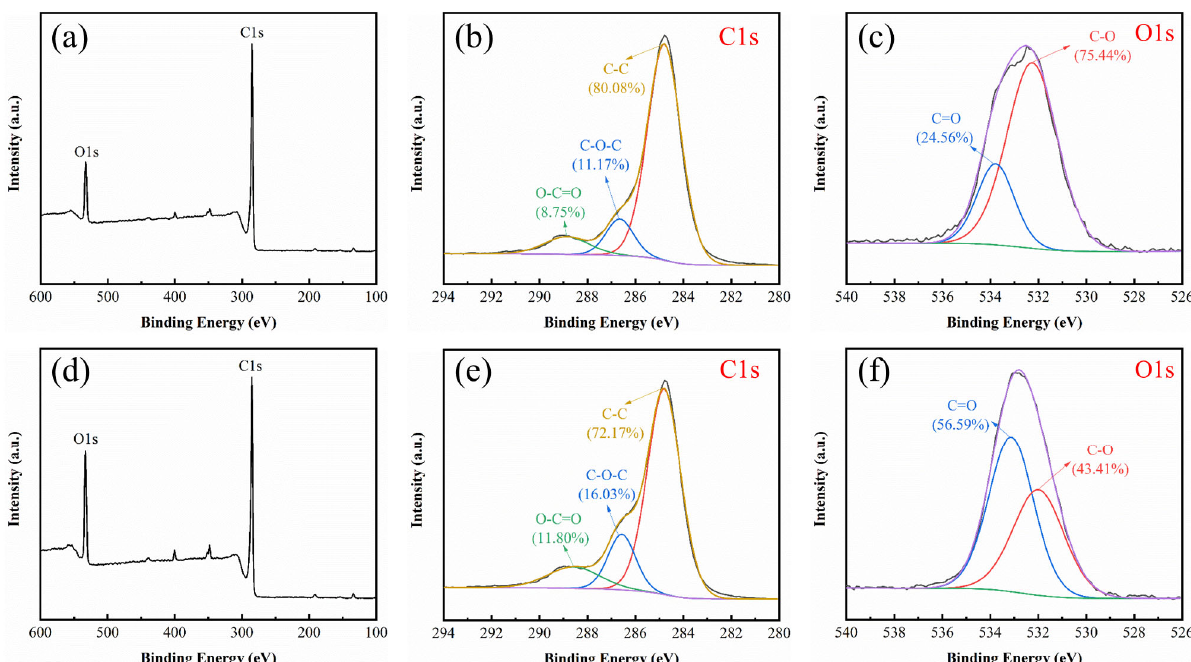
Figure 4. Study of elemental composition and surface chemical states of BBC-HAP and BBC-HAP-Colorant by ( a ) and ( d ) XPS spectra, ( b ) and ( e ) C1s spectra and ( c ) and ( f ) O1s spectra.